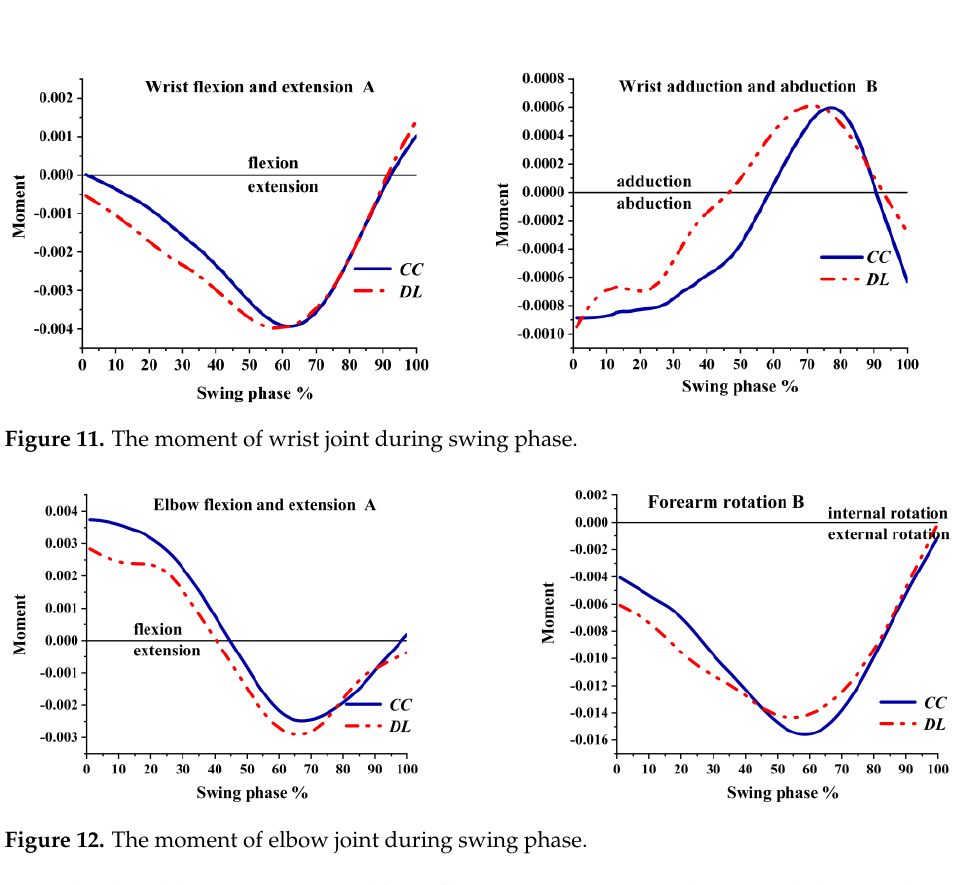
Figure 13. The moment of shoulder joint during swing phase.